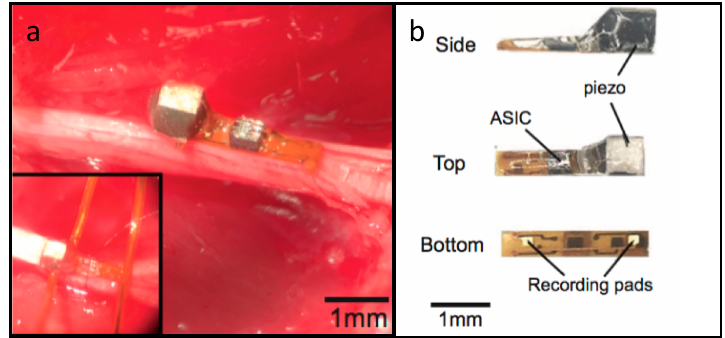
Figure 6. ( a ) Nervous system recorder placed in the sciatic nerve of a rat and ( b ) layout of the device. Reproduced with permission from [16].